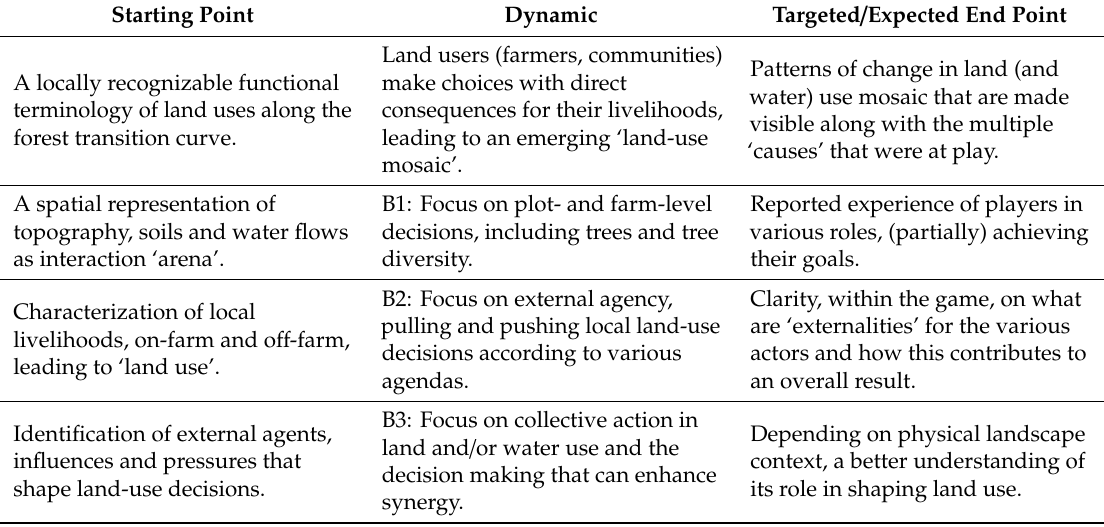
Table 5. Prototype of a who? what? where? land and water use game, with targeted / expected endpoints as hypothesis for further corroboration; type B in Figure 10 Starting Point